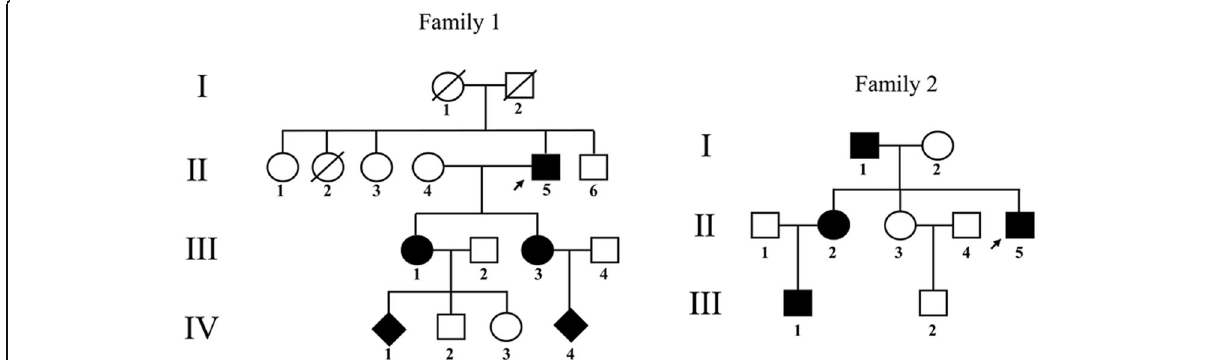
Fig. 1 Pedigrees of the two families with DA2B (Family 1) and mild DA1 (Family 2). Arrows indicate the probands in each